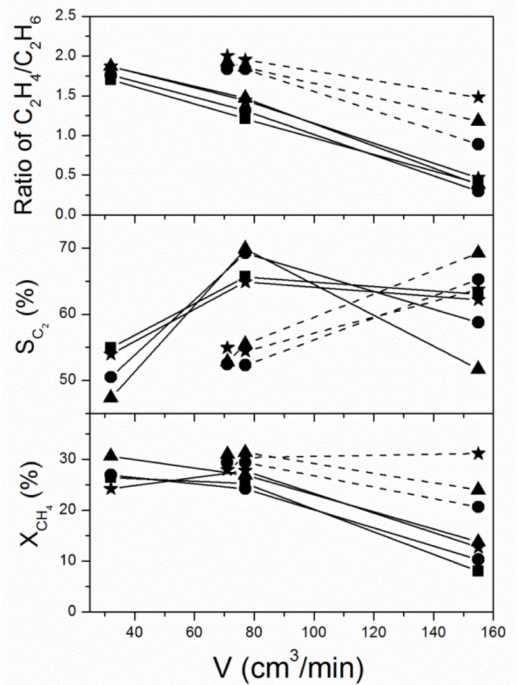
Figure 7. Influence of diluting feedstock with inert gas (helium) on the OCM process. Reaction conditions: T = 1053 K; m cat = 400 mg; molar ratio of CH 4 :O 2 = 3.3 (in all cases); total flow rate = 77 cm 3 · min − 1 ; V CH4 :V O2 = 14.4:4.3 (solid line); V CH4 :V O2 : = 37.8:11.3 (dotted line). Sym- bols: ( (cid:4) ) biogas 1 (as source of methane), ( (cid:78) ) biogas 2 (as source of methane), ( • ) mixture of CH 4 + CO 2 + O 2 + He, ( (cid:70) ) mixture of CH 4 + O 2 +